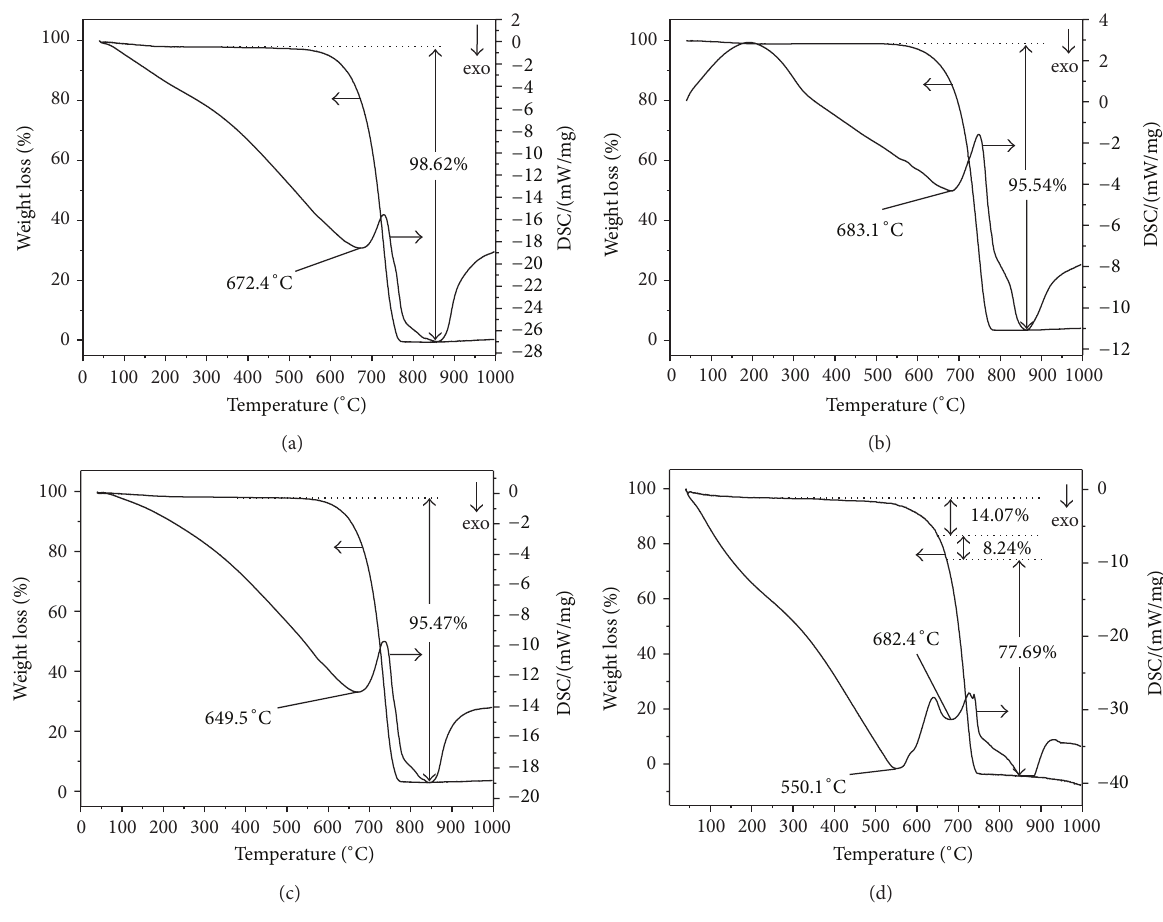
Figure 6: TG-DSC thermalgrams for CN-T (a), CN-D (b), CN-M (c), and CN-U (d).